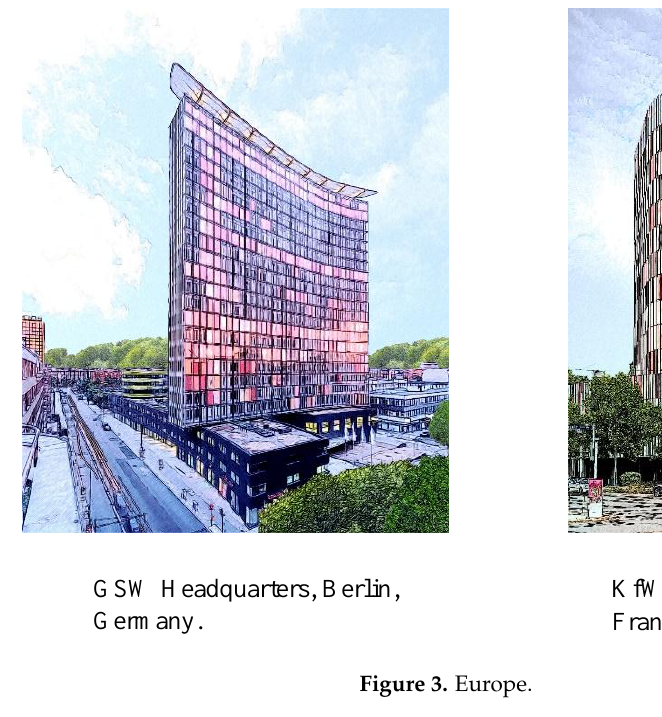
Figure 3. Cont. Figure 3.